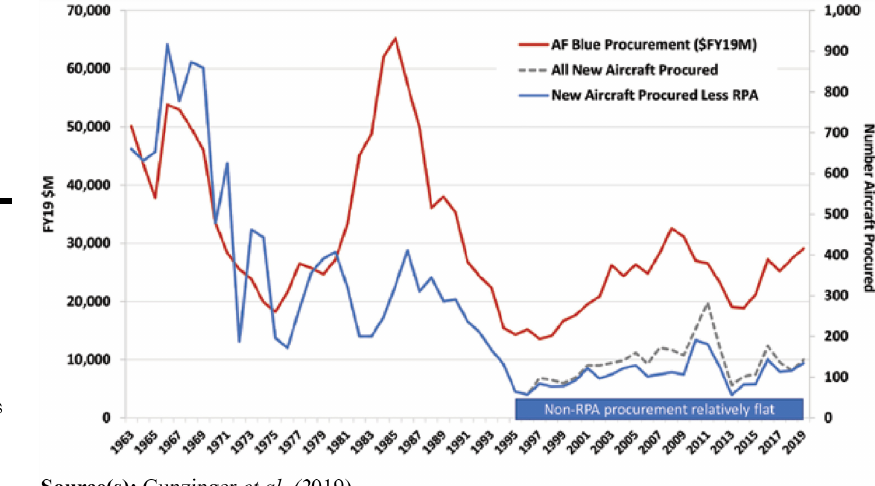
Figure 2. Trends in the USAF ’ s total BLUE procurement funding and aircraft